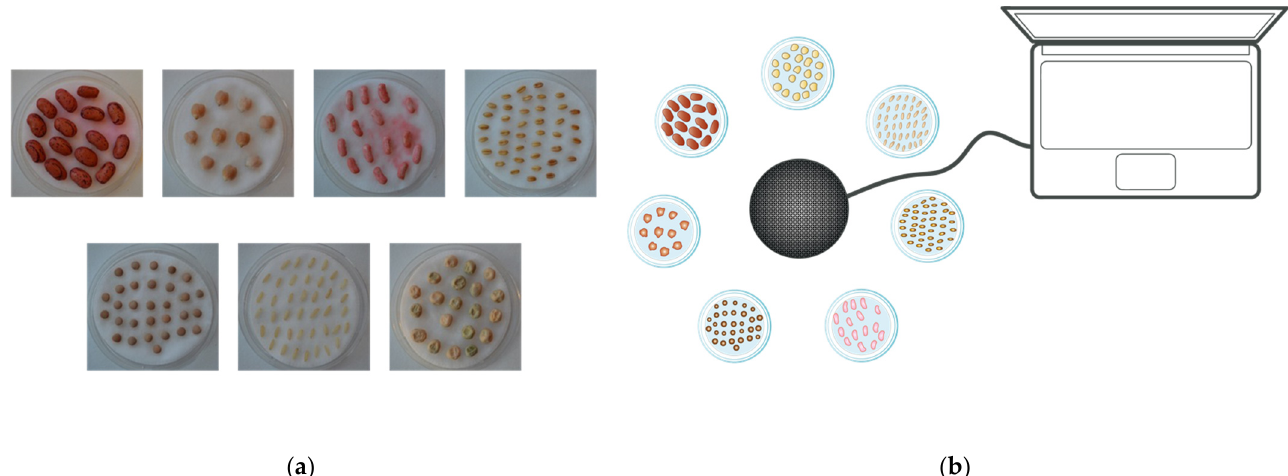
Figure 1. Overview of the experimental setup with the seed plates ( a ) and their arrangement relative to the wave emitter ( b ). to the wave emitter ( b